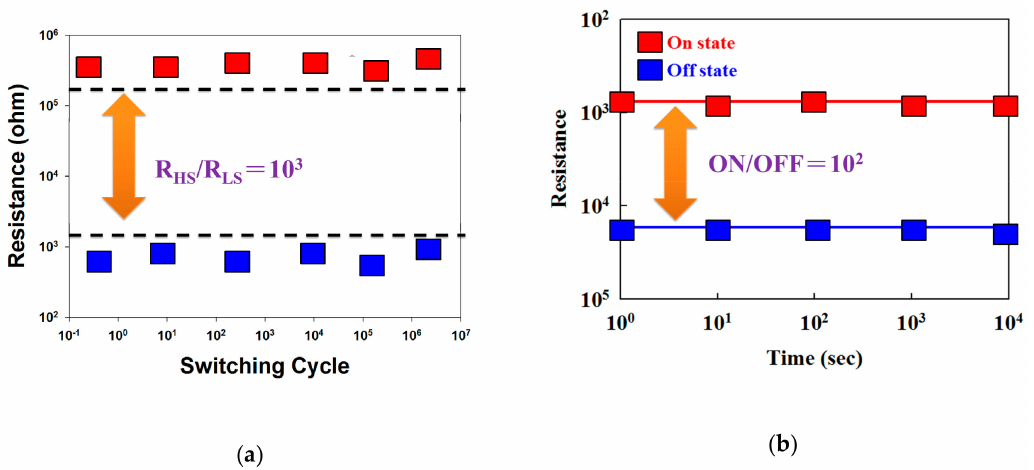
Figure 8. ( a ) Endurance cycle and ( b ) retention time properties of the Al / V 2 O 5 / Sm 2 O 3 / TiN / SiO 2 / Si devices at room temperature, as measured at 0.2